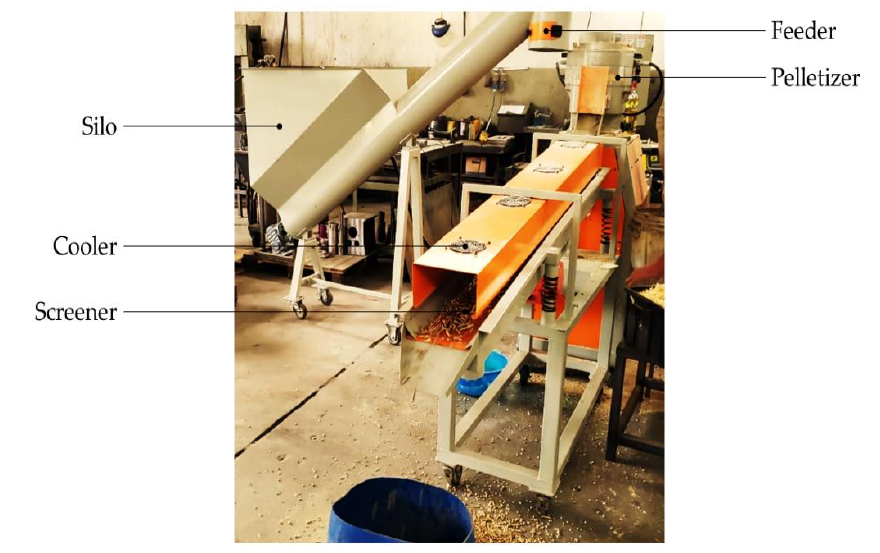
Figure 6. Pilot-scale integrated set for pelleting.